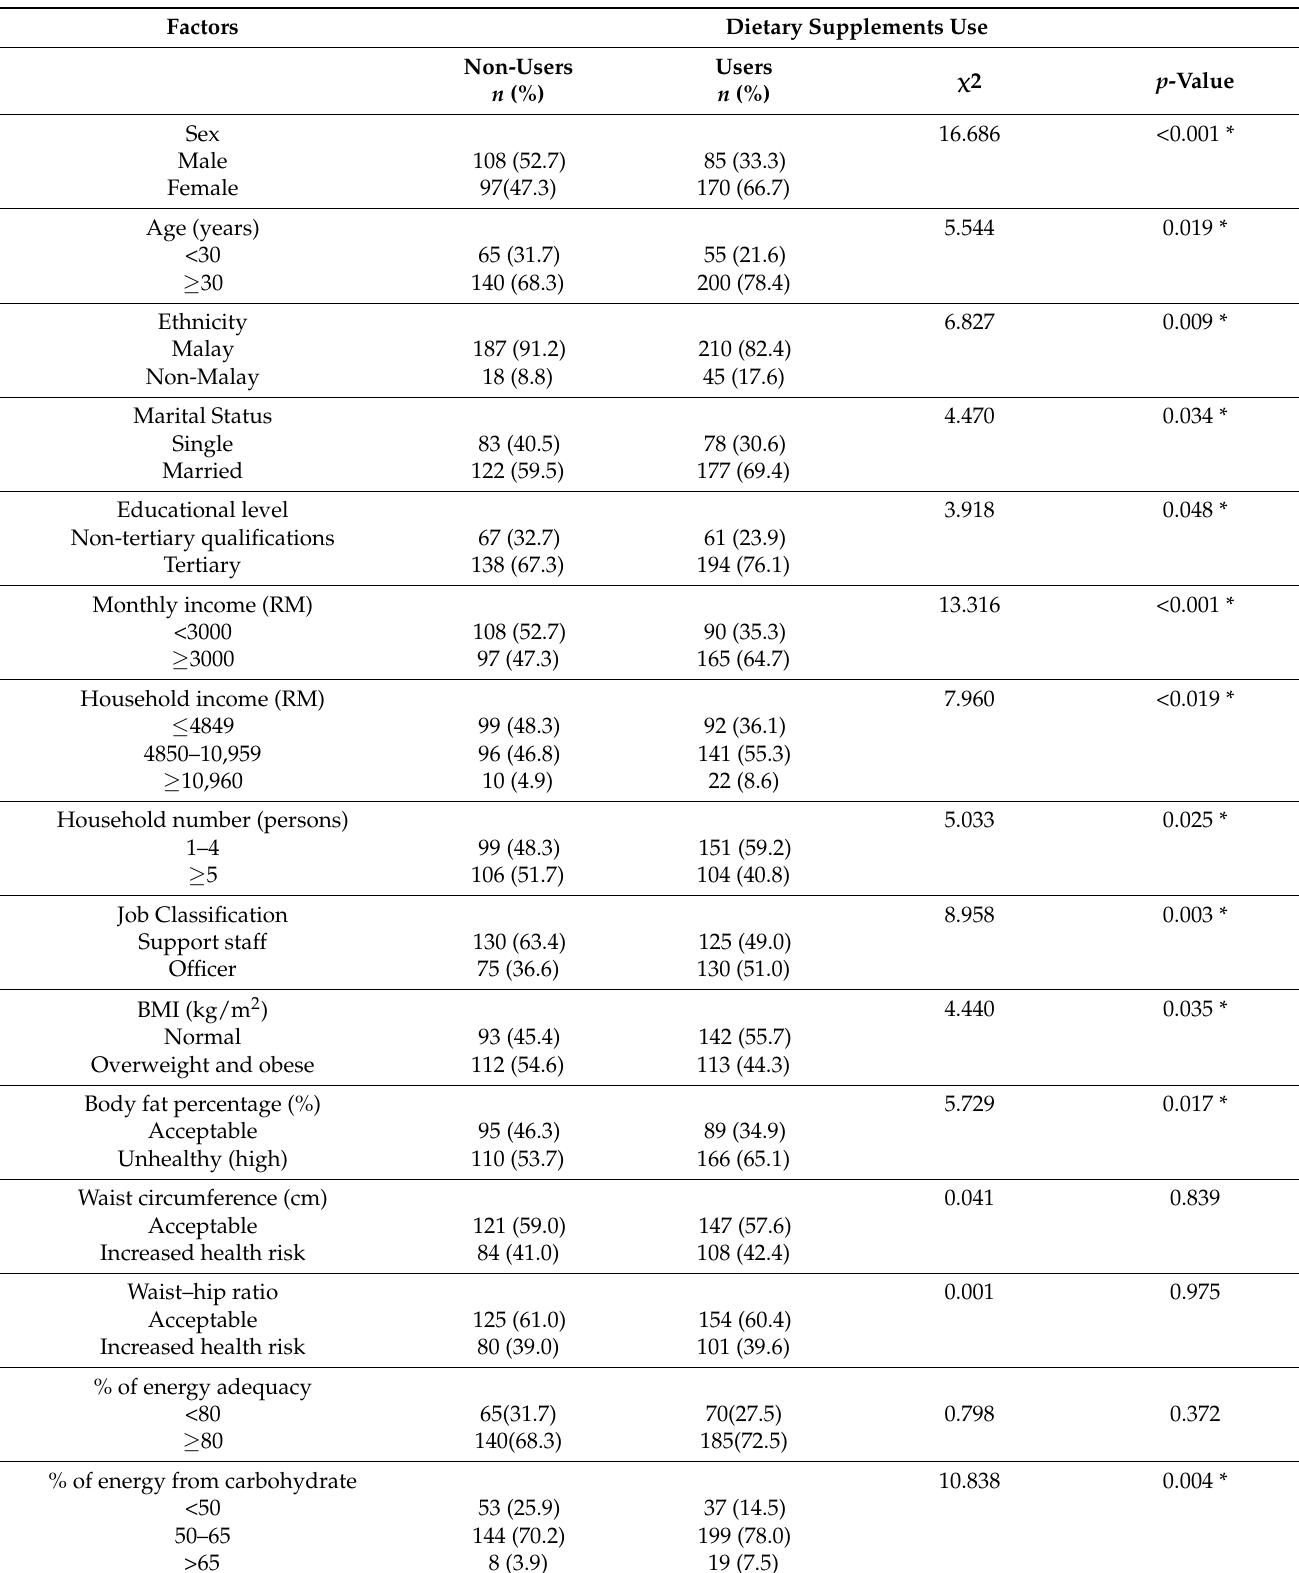
Table 2. Associations among sociodemographic characteristics, body weight status and dietary intake with dietary supplements use among